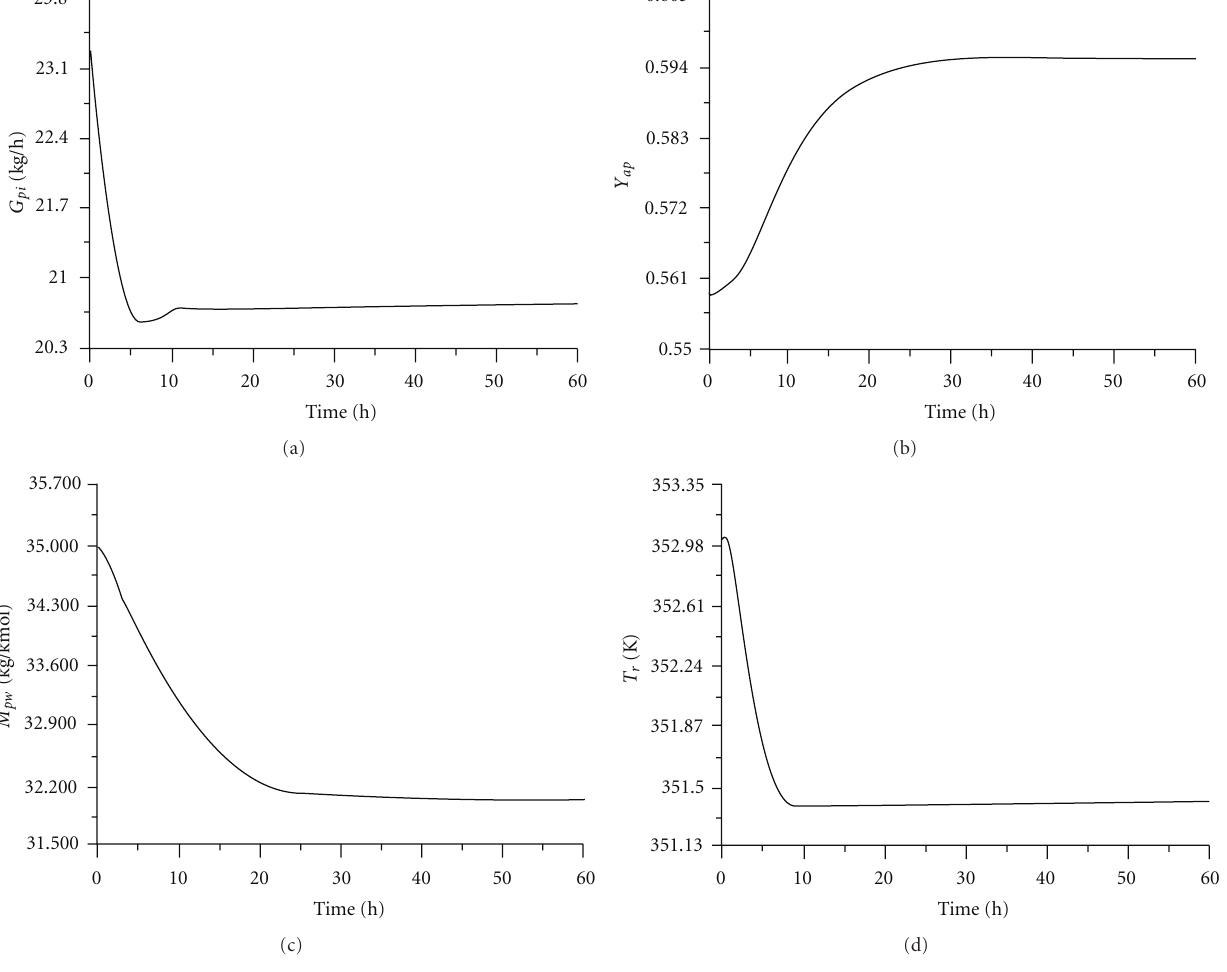
Figure 2: Open-loop simulation to inhibitor